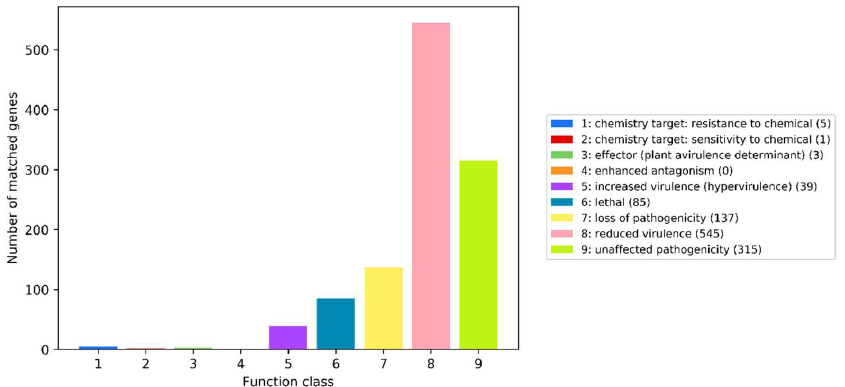
Figure 8. The distribution of pathogen–host interaction (PHI) genes in Starmerella bacillaris CC-PT4. Table 5. Starmerella bacillaris CC-PT4 virulence analysis.